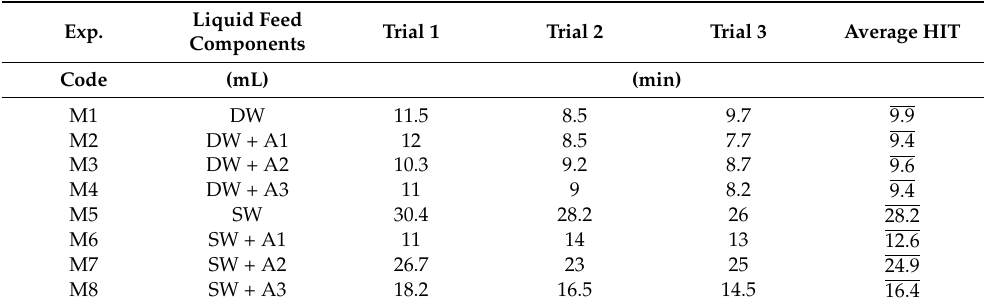
Table 2. Influence of promoters and their blends on the gas hydrate induction times (HITs) of pure water and